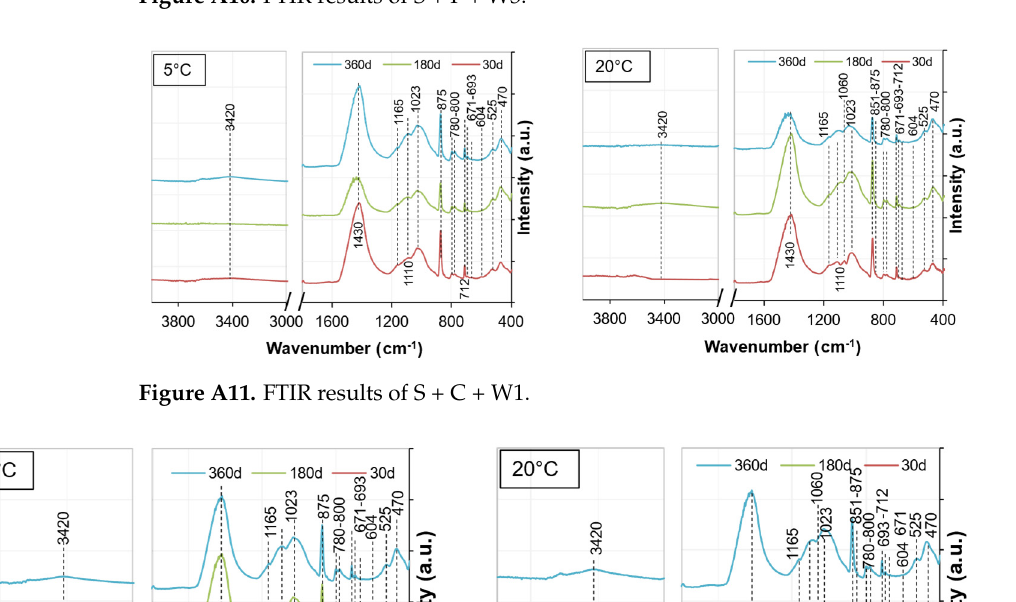
Figure A10. FTIR results of S + F + W3.